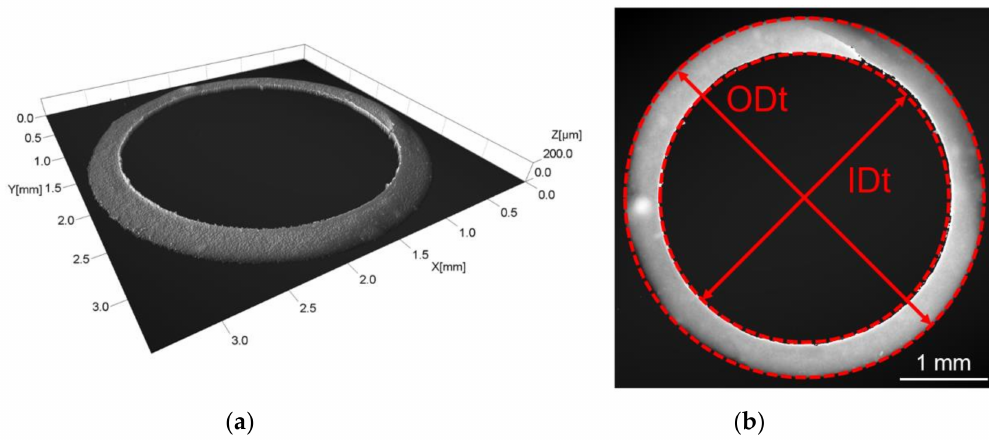
Figure 4. Measurement performed with the focus variation microscope: ( a ) 3D acquisition of the top of the micro part reproduced with permission from [23]; ( b ) measurement of ODt and IDt by fitting the corresponding